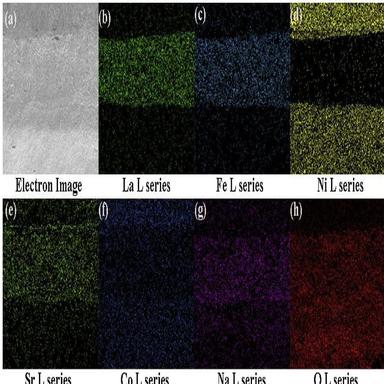
The elemental mapping obtained by EDS of cross-sectional cell: (a) electron image, (b) La, (c) Fe, (d) Sr, (e) Na, (f) Ni, (g) Co,(h) Al and (i) O element.